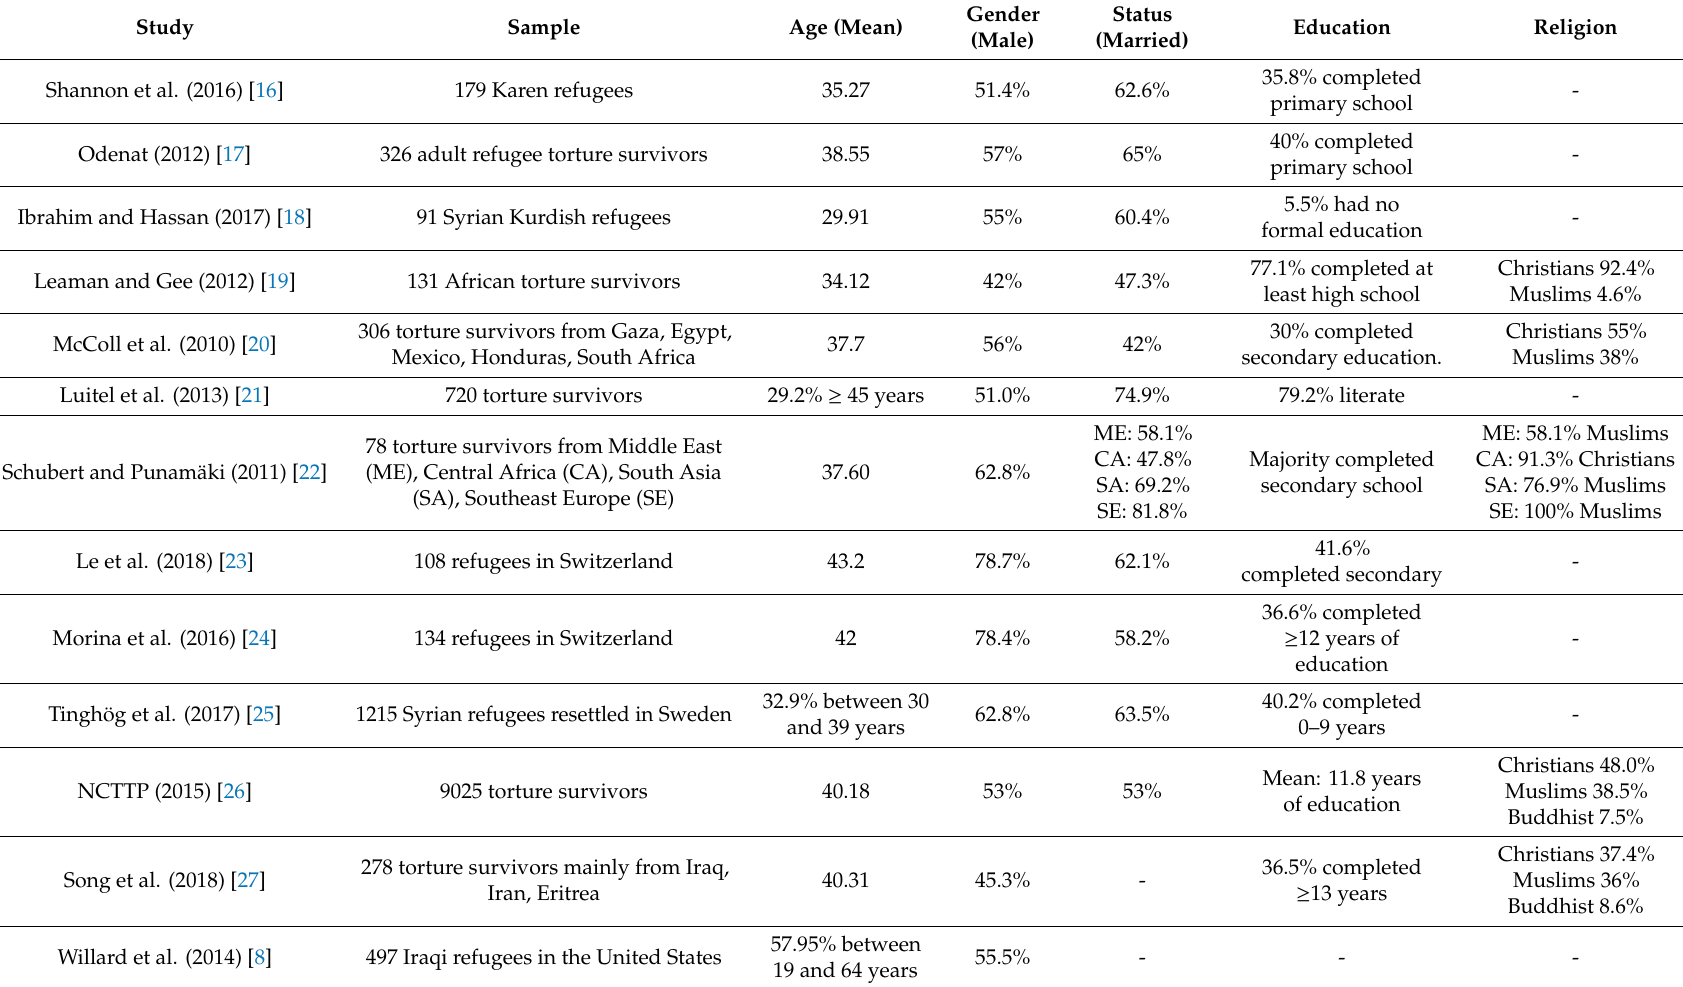
Table 1. Demographics of refugees and torture